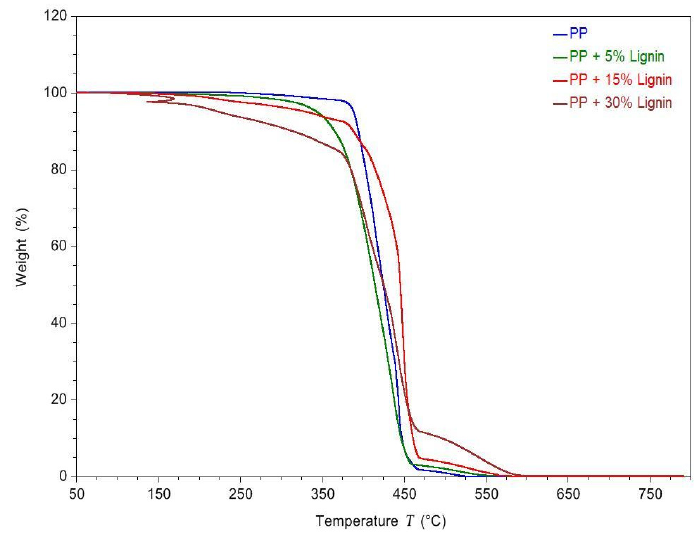
Figure 5. TGA curves for different blends of PP-lignin.